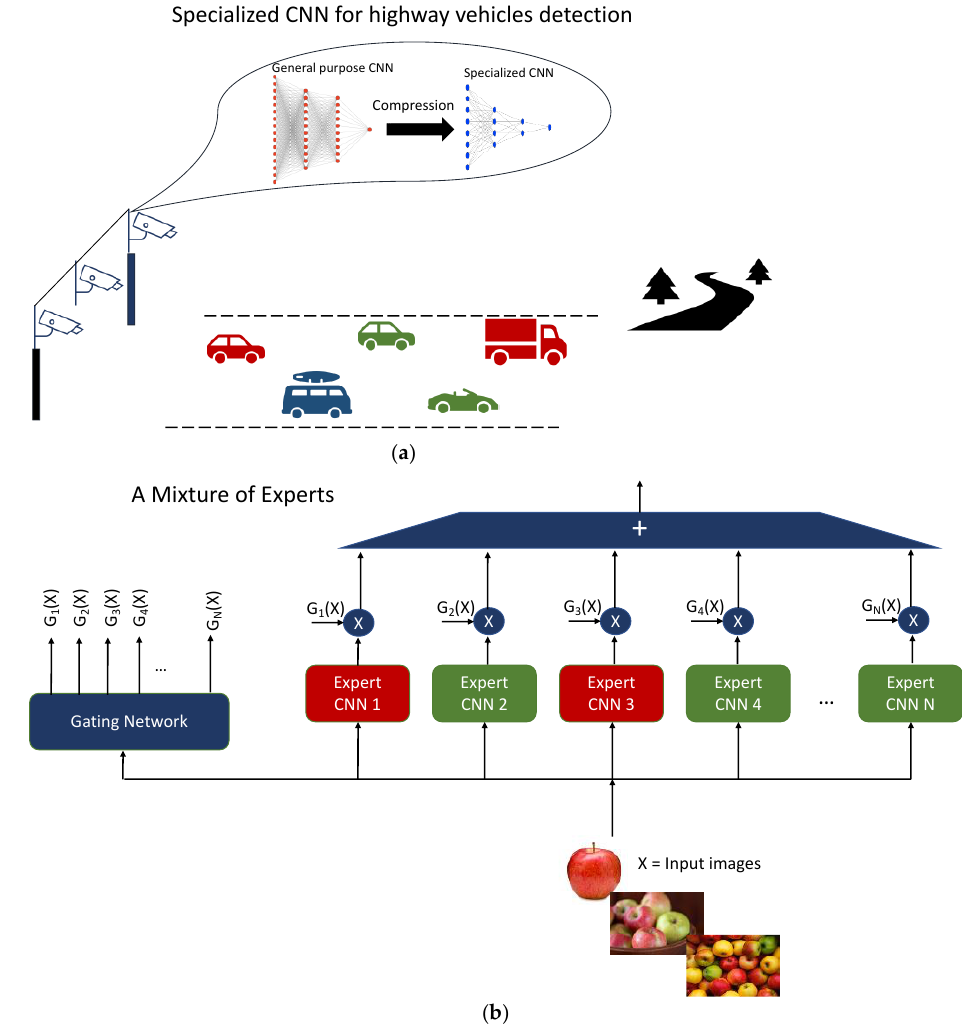
Figure 1. Illustrative examples of specialized CNNs: ( a ) specialized CNN for highway vehicle detection and ( b ) a mixture of expert CNNs.